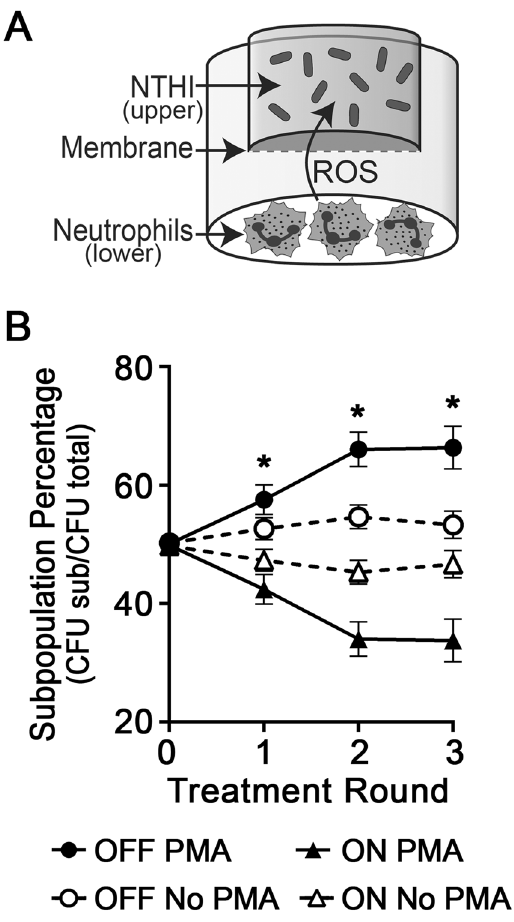
Figure 6. Exposure to ROS generated by human neutrophils selected for the modA2 locked OFF subpopulation. ( A ) NTHI and activated neutrophils were physically separated by a 0.4 µ M pore membrane to prevent physical contact or phagocytosis, yet permit the diffusion of ROS. Neutrophils were seeded into the lower chamber of a Transwell system and activated with 50 nM PMA for 10 minutes. NTHI were then added to the upper chamber of a Transwell and incubated for 30 min to allow exposure to ROS. ( B ) A mixed culture that contained an equal number of modA2 locked ON:GFP and modA2 locked OFF:mCherry was subjected to multiple rounds of exposure to neutrophil-derived ROS. The increased sensitivity of modA2 locked ON to ROS resulted in an enrichment of the modA2 locked OFF subpopulation. Selection was apparent after the first round of exposure to ROS. The population percentages, modA2 locked ON compared to modA2 locked OFF, were significantly different after the first round, * P < 0.005, unpaired t-test. This difference remained significant after each subsequent round of exposure to ROS, * P < 0.005, multiple t-tests. These data suggest that ROS due to infiltrating immune cells will contribute to selection for the modA2 OFF